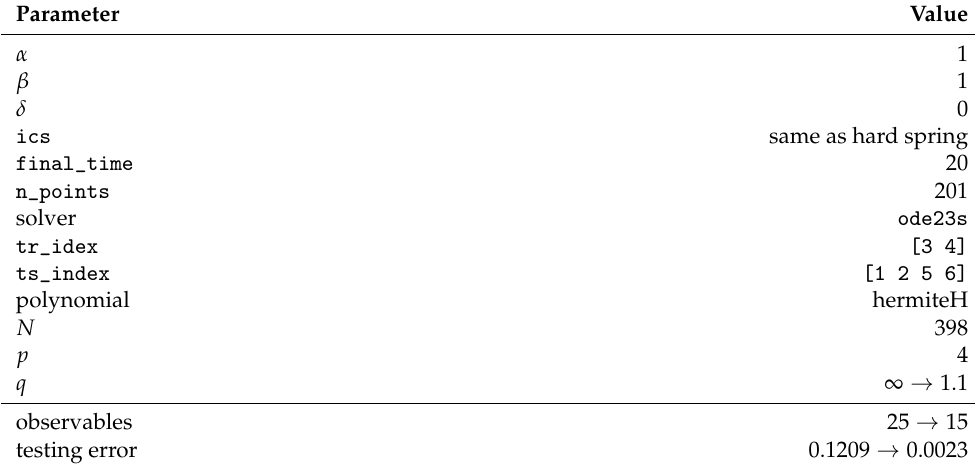
Table 3. Approximation parameters for the undamped Duffing